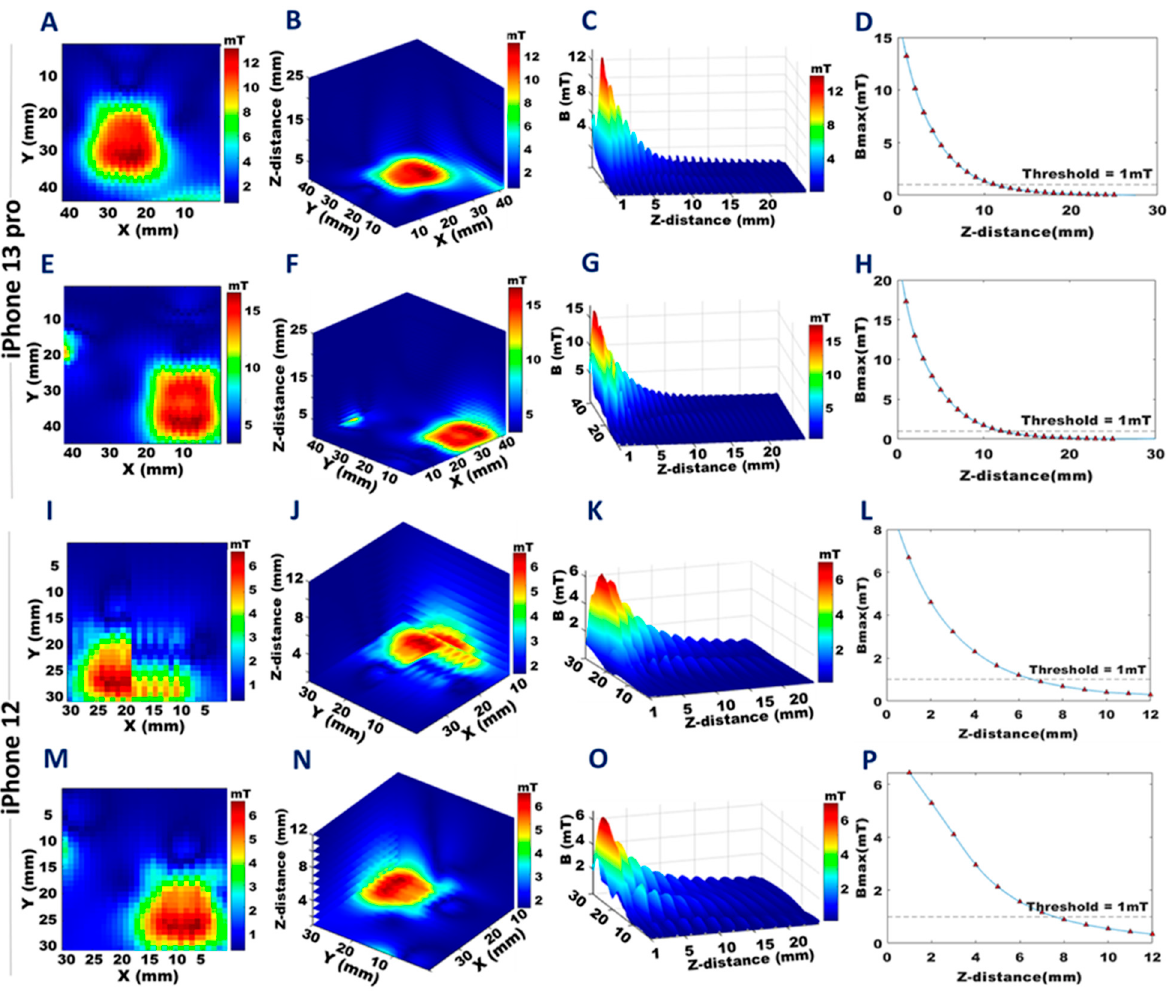
Figure 5. Distribution of the stray magnetic field of the cameras of the iPhone 13 Pro and the iPhone 12. The colors represent the strength of the magnetic fields and are scaled to the maximum B-field of each data set. A , E , I , and M : The 2D distribution of the stray magnetic fields of the cameras for a transversal plane located at a distance of 1 mm from the back ( A ), ( I ) and from the front ( E ), ( M ) of the iPhone 13 Pro and the iPhone 12. B , F , J , and N : The 3D distribution of the stray magnetic fields of the cameras covering a z-distance of z = 1–25 mm from the back ( B ), ( J ) and at z = 1–12 mm from the front ( F ), ( N ) of the iPhone 13 Pro and the iPhone 12. C , G , K , and O : The 3D stray magnetic field ( B ) variation with the increasing z-distance from the back ( C ), ( K ) and front ( G ), ( O ) of the iPhone 13 Pro and iPhone 12’s cameras, respectively. D , H , L , and P : Maximum stray magnetic field (B max ) versus the z-distance from the back ( D ), ( L ) and from the front ( H ), ( P ) of the iPhone 13 Pro’s camera and the iPhone 12 ′ s camera.